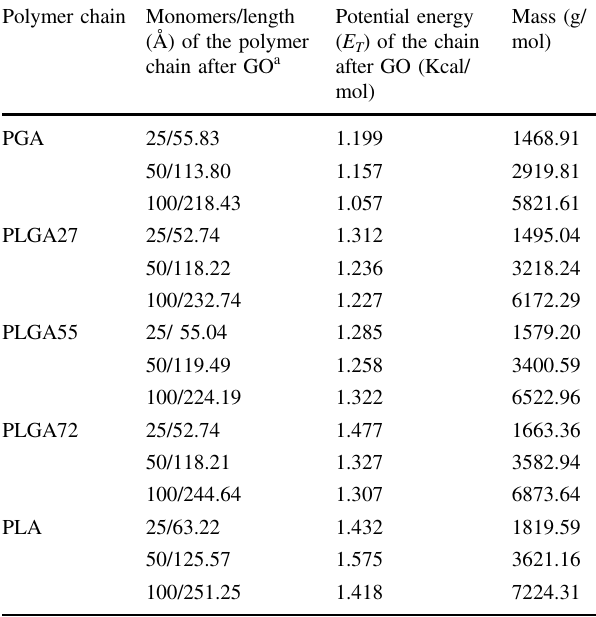
Table 1 Characteristics of various polymer chains considered for docking and MD